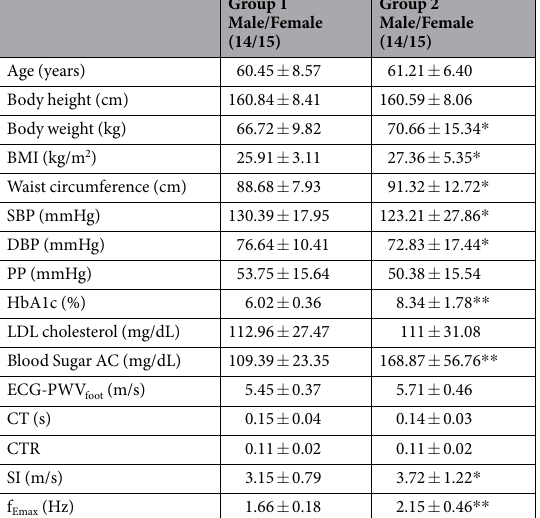
Baseline characteristics of study subjects. (Table 1). On the other hand, the systolic (SBP) and diastolic blood pressure (DBP) were lower in Group 2 than those in Group 1 (both p < 0.05). Comparison of computational parameters between diabetic and non-diabetic patients. There was no significant difference in ECG-PWV foot , CT and CTR between subjects without diabetes (Group 1) and those with the disease (Group 2) ( p = 0.082, 0.287, and 0.896, respectively) (Table 1). However, stiffness index (SI) and instantaneous energy of maximal energy (f Emax ) were significantly higher in the diabetic patients (Group 2) than those in the non-diabetic subjects (Group 1) ( p < 0.05 and < 0.001, respectively) (Table 1, Fig. 1).